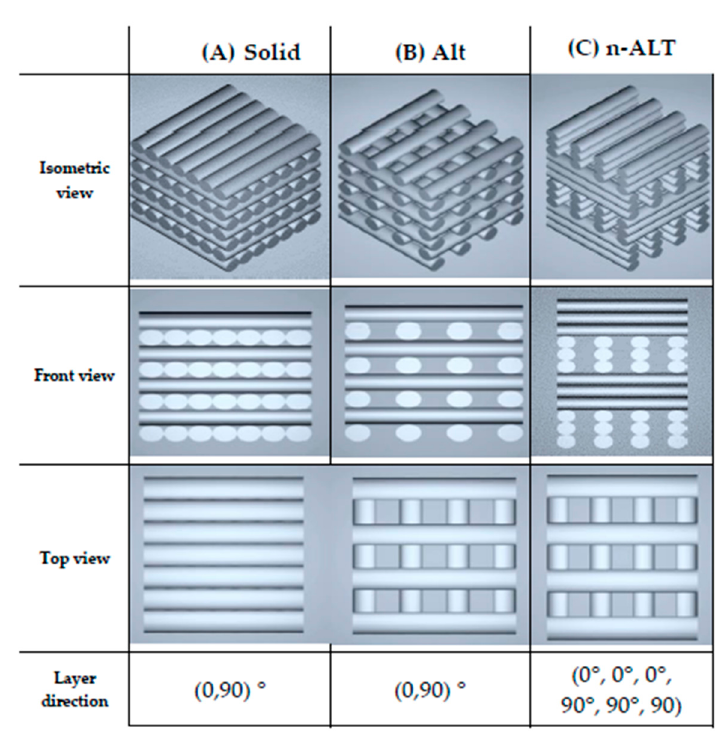
Figure 1. STL (Standard Tessellation Language) images of ( A ) solid (100% infill), and 30% ( B ) alternate (ALT) and ( C ) non-alternate (n-ALT) sca ff olds.